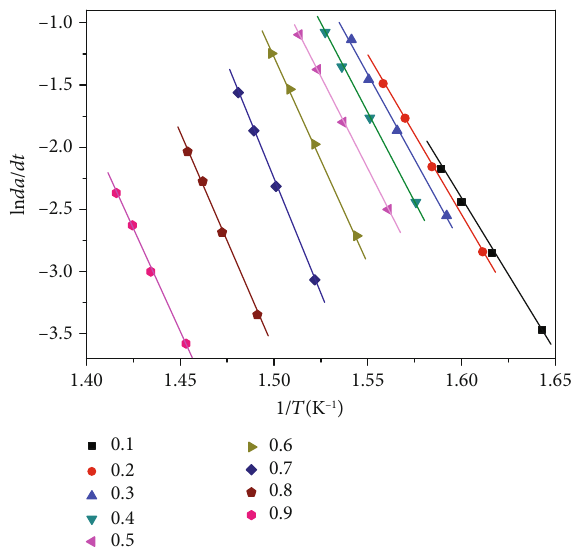
Figure 4: Representative plot of ln ½ d α · ð dt Þ − 1 (cid:2) versus T − 1 determined by the Friedman method of pure NR with conversion ranging from 0.1 to 0.9.